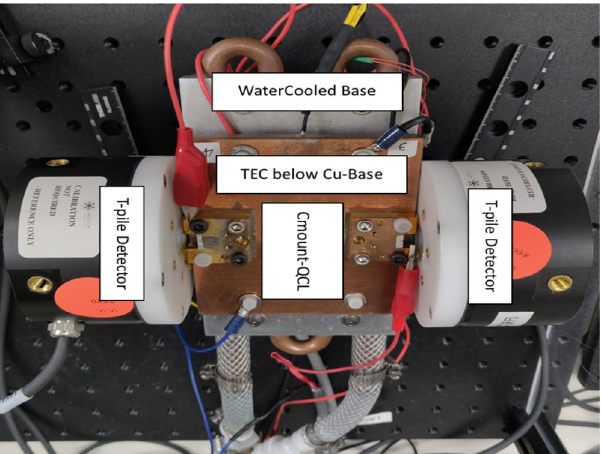
Figure 1. QCL Mount with integrated water-cooled TEC for high temperature accelerated lifetime